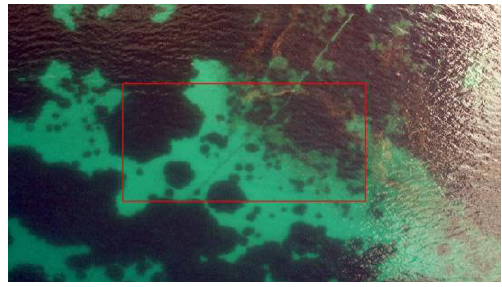
Figure 2 Selected subset on the orthophoto-maps.